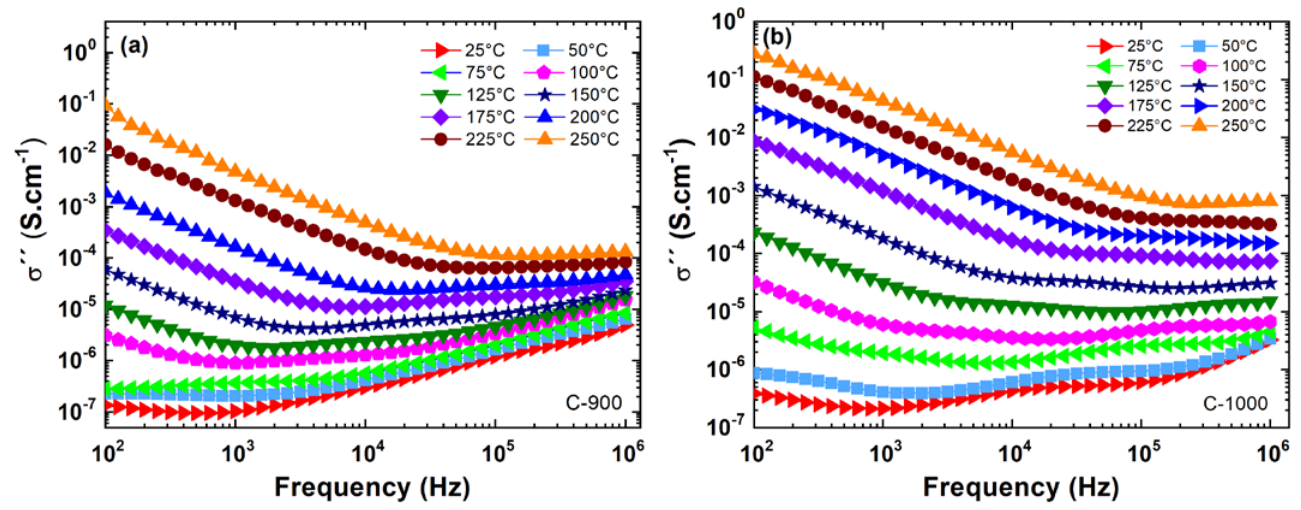
) versus frequency ( ) for ceramic pel- ′′ 𝜎𝜎 𝑓𝑓